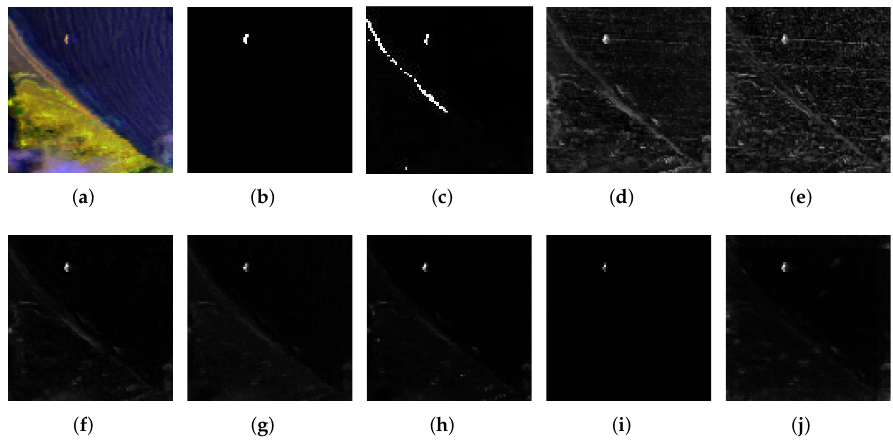
Figure 10. Visual detection results of all the algorithms on the Bay Champagne dataset. ( a ) Pseudo- color image. ( b ) Ground-truth. ( c ) BEGAIP. ( d ) LRASR. ( e ) GTVLRR. ( f ) LSMAD. ( g ) RX. ( h ) RPCA. ( i ) LRX. ( j )